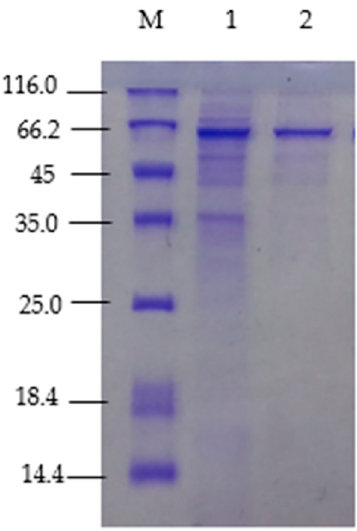
Figure 3. The SDS-PAGE analysis of purified GlaEst12 esterase. Lane M: unstained protein marker (Thermo Scientific, Waltham, MA, USA); Lane 1: refolded GlaEst12; Lane 2: purified GlaEst12-like esterase via Ni-Sepharose affinity chromatography.